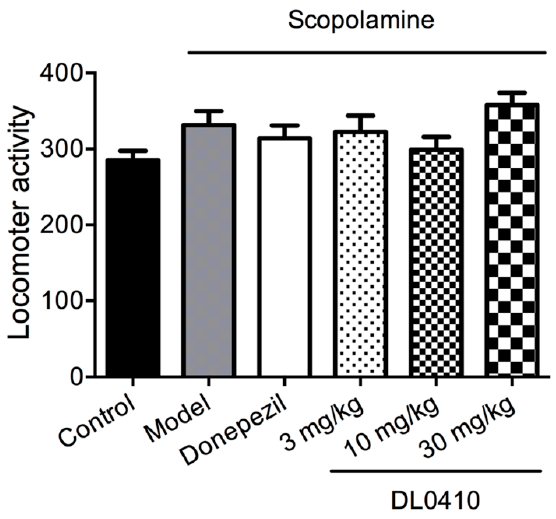
Figure 2. The effect of DL0410 on locomotor activity. There were no significant differences among groups. Data are expressed as mean ± SEM ( n = 12). groups. Data are expressed as mean ± SEM ( n =